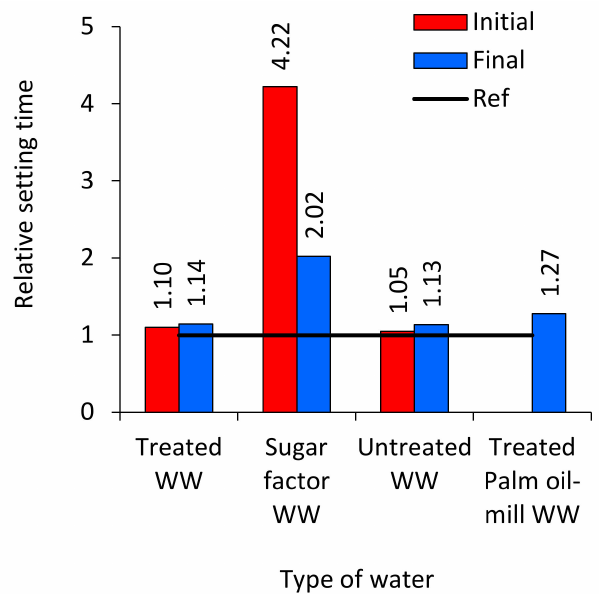
Figure 4. Effect of different types of WW on the setting time of